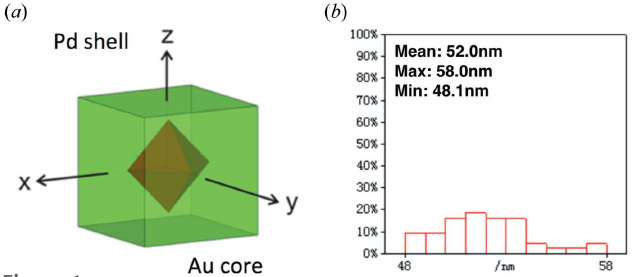
Figure 1 Information for the core–shell nanoparticle. ( a ) Schematic drawing of an Au–Pd core–shell nanoparticle. The green cube indicates the outer shell of the particle composed of palladium (atomic number 46), while the red core is composed of gold (atomic number 79). ( b ) Size distribution of nanoparticles obtained from electron microscope imaging. The sizes range from 48.1 to 58.0 nm, with a mean value of 52.0 nm.